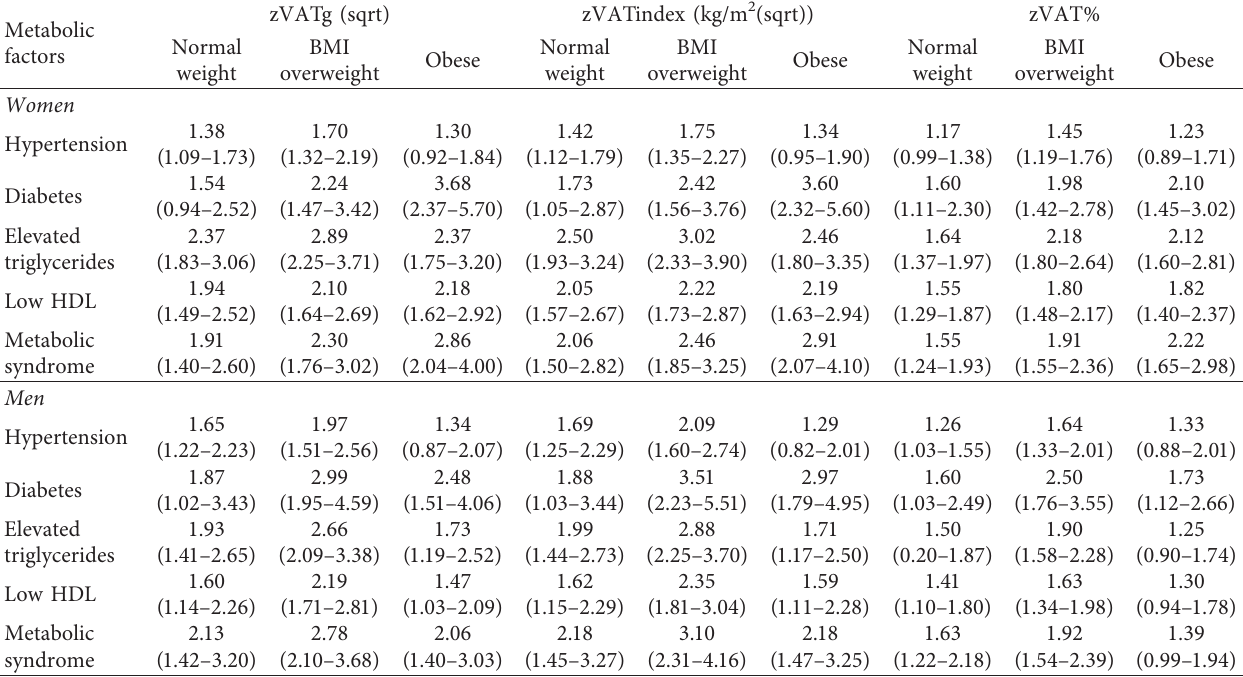
Table 4: Age-adjusted OR for the association of metabolic syndrome and single metabolic components and standardized/z-scores of VAT mass in categories of body mass index (BMI): the Tromsø Study 2015–2016. factors